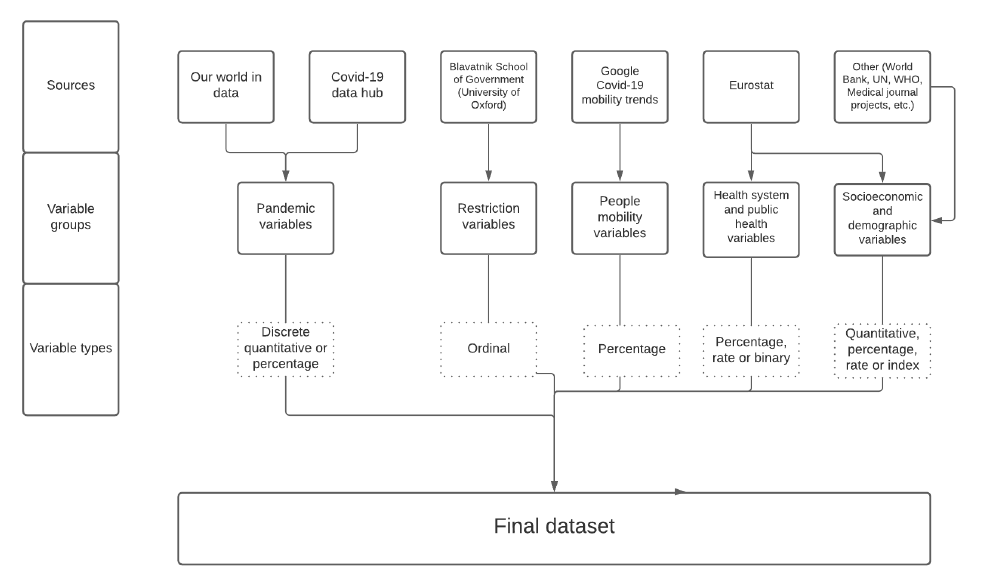
Figure 1. Sources and structure of the dataset used for the